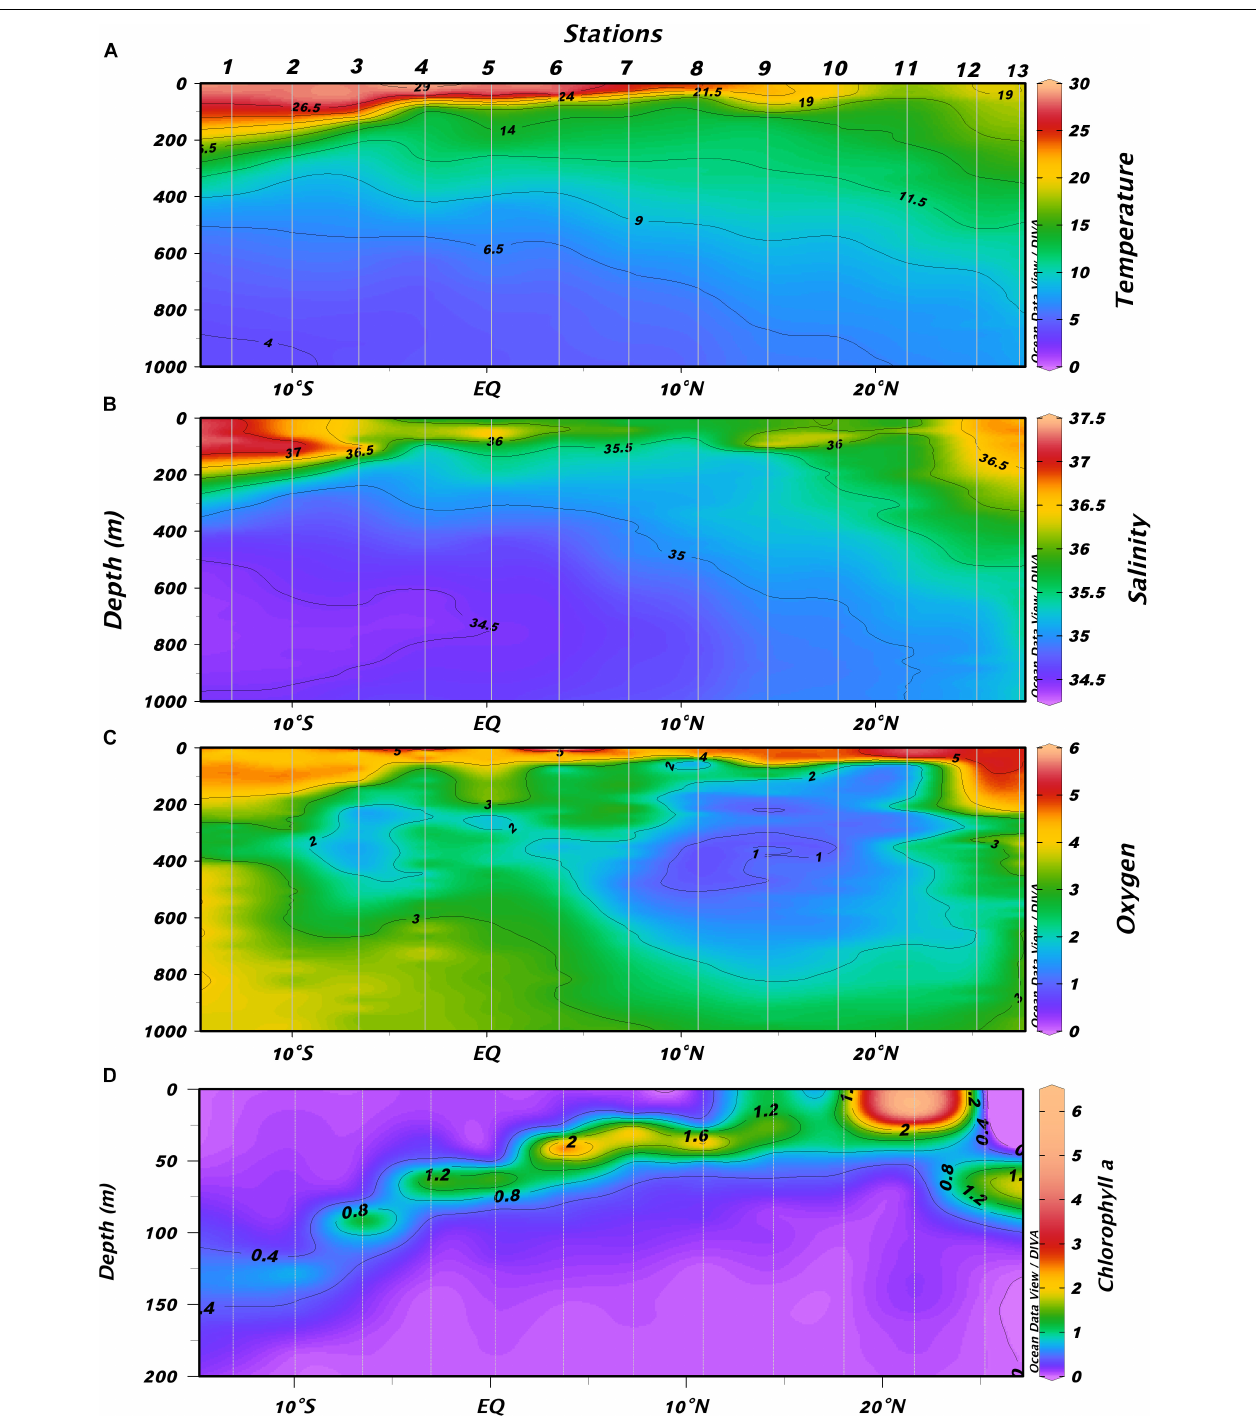
FIGURE 2 | Vertical distribution of (A) temperature ( ◦ C), (B) salinity, (C) oxygen (ml · l − 1 ), and (D) chlorophyll (mg · m − 3 ) along the transect performed in the tropical and subtropical Atlantic Ocean during the cruise.